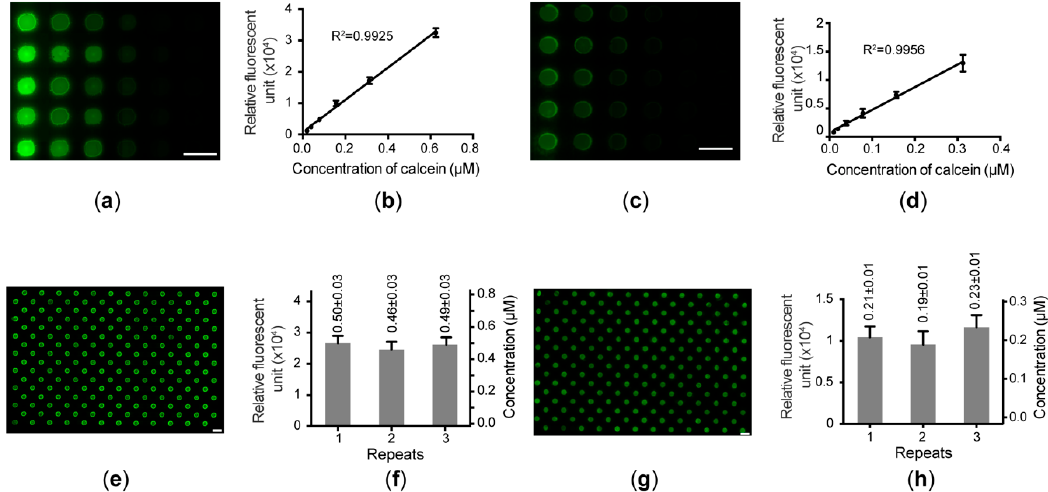
Figure 6. Quantitative characterization of nanoliter-volume liquid dispensing using the NanoCLD. ( a ) Fluorescent image of the microwells with a gradient of calcein dispensed into the reagent chip using the NanoCLD. ( b ) Linear relationship between the calcein concentrations and the fluorescence intensities of the microwells (n = 5). ( c ) Fluorescent image of the microwells with calcein delivered into the cell chip. ( d ) Linear calibration between the calcein concentrations and the fluorescence intensities (n = 5). ( e ) Chessboard pattern produced in the reagent chip using the NanoCLD. ( f ) Relative fluorescent units and corresponding calcein concentrations of microwells across the entire reagent chip in three independent repeats (n = 192 in each run). ( g ) Fluorescent image of the cell chip sandwiched with the reagent chip with the chessboard pattern. ( h ) Relative fluorescent units and converted calcein concentrations of microwells in the cell chip in three independent runs (n = 192 in each run). (scale bar: 1.5 mm).